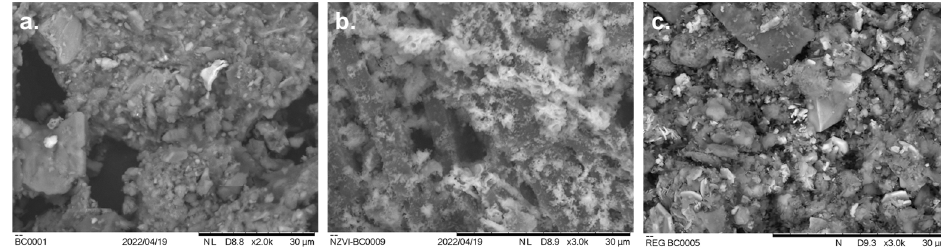
Figure 2. SEM images of bare ( a ) BC, ( b ) nZVI-BC, and ( c ) FS treated . Table 1. Results of EDS analysis for BC, nZVI-BC, and FS treated . Element,